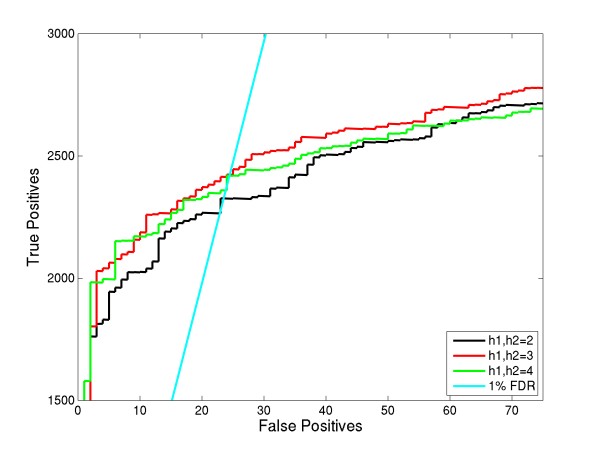
OMSSA noise filter improvements. This figure compares the different options in OMSSA noise filter (h1 and h2) for spectra searched for 3 ion species. By default, OMSSA sets a value of 2 for these parameters. Looking at the ROC plot, we modified these parameters "h1" and "h2" to be equal to the number of ions searched for, to yield higher sensitivity without loss in specificity.